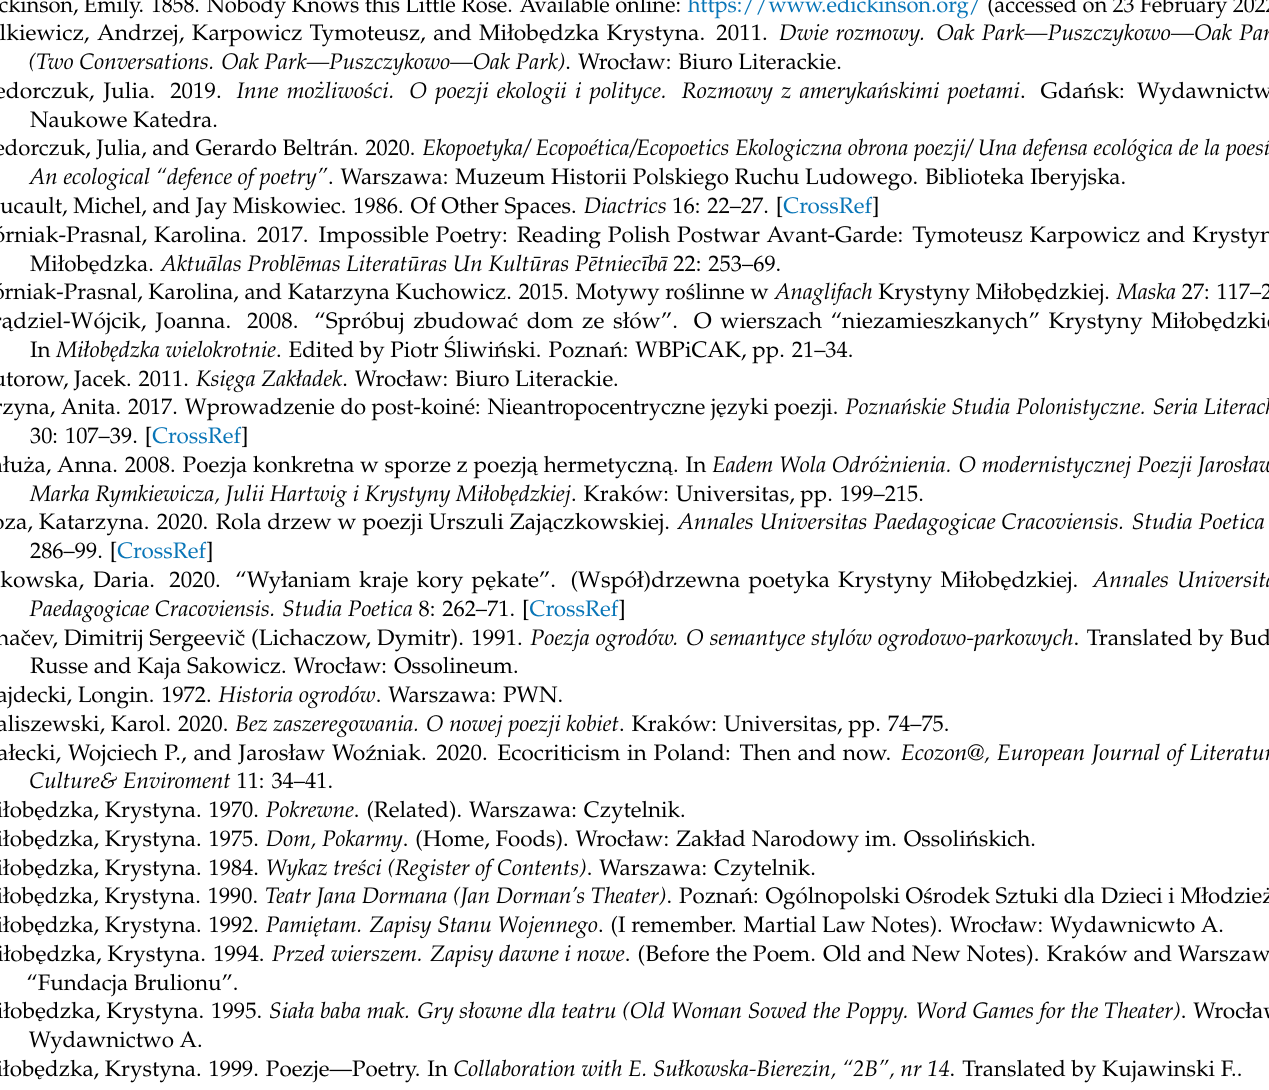
Figure 10. photography by J˛edrzejczak, Paweł. Mural of a poem by Krystyna Miłob˛edzka, jestem do znikania (I am to desappeare) in Figure 11. photography by J˛edrzejczak, Paweł. Mural of a poem by Krystyna Miłob˛edzka, wr ó ´c i b ˛ad´z jeszcze dalej (come back and be still more) on the wall of library in Puszczykowo. The mural was made in a frame of project “Młodzie˙z w działaniu” (Youth in Action), coordinated by Magda Nowicka